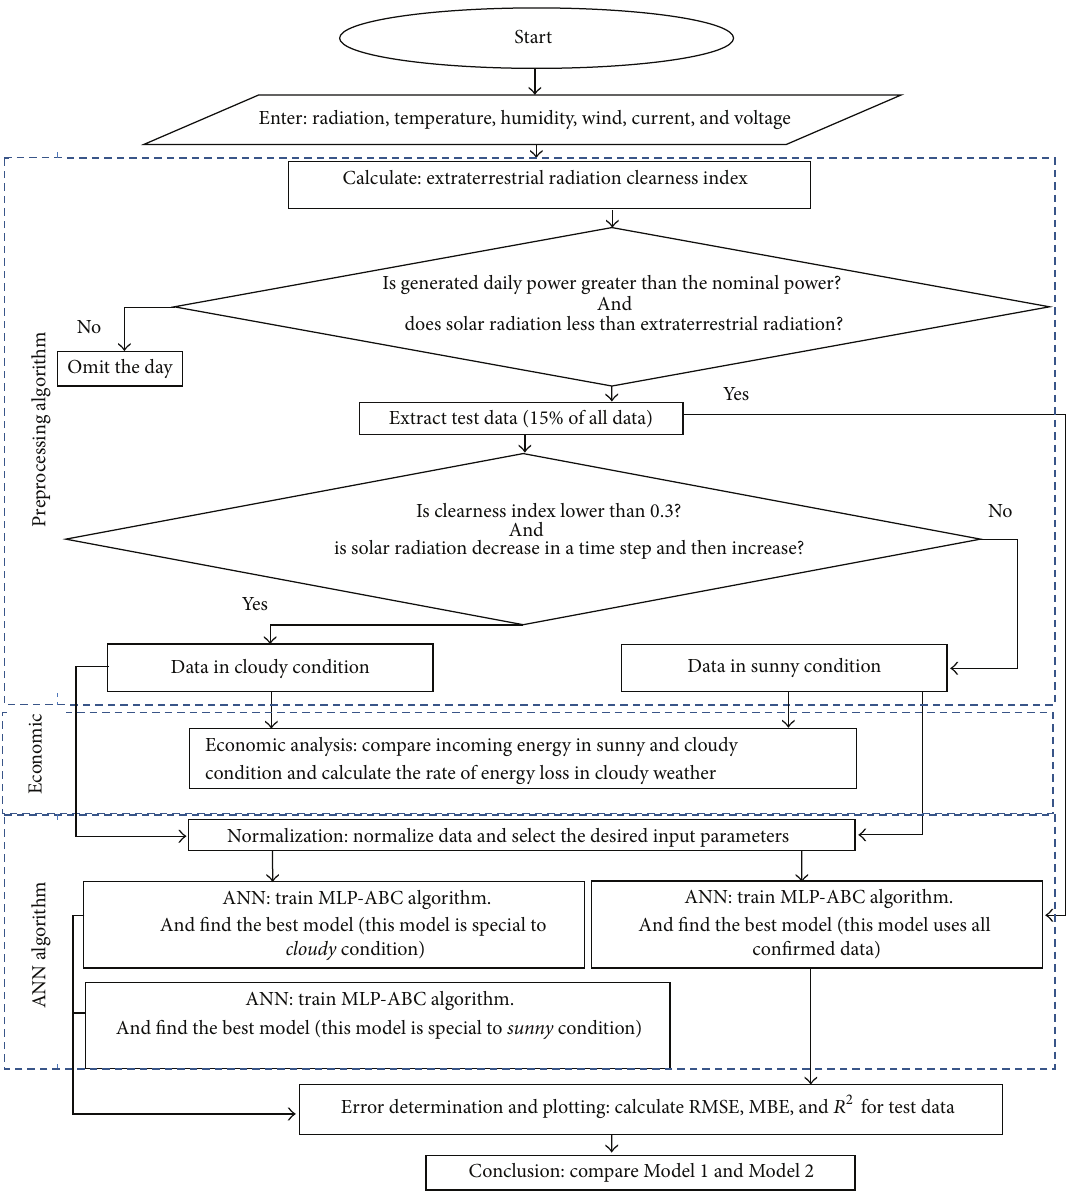
Figure 2: Data selection method, preparation for feed-forward neural network, and output